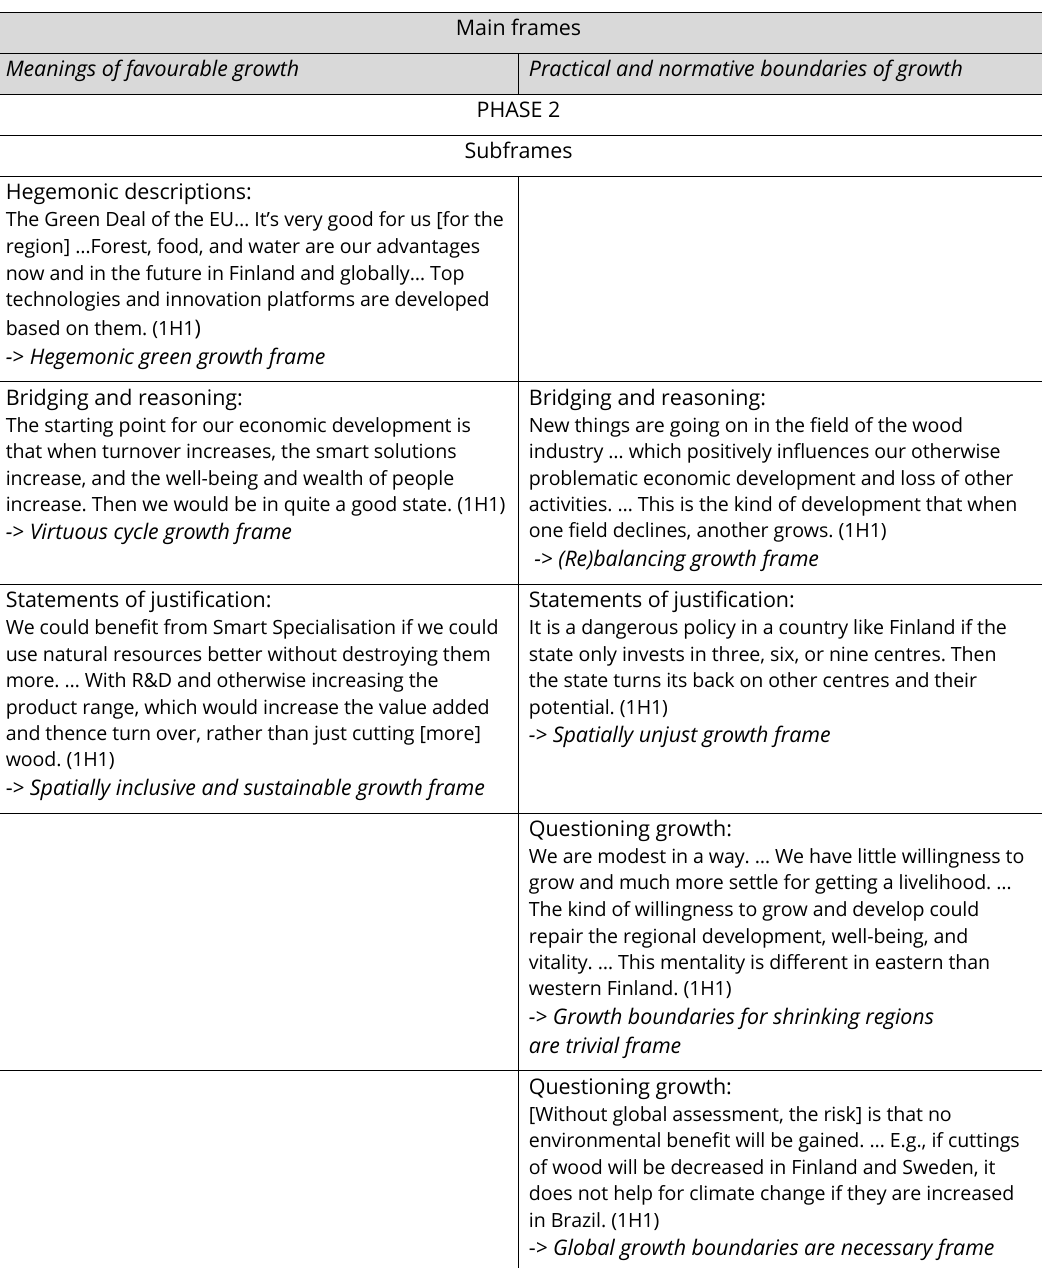
Table 1. The process of frame